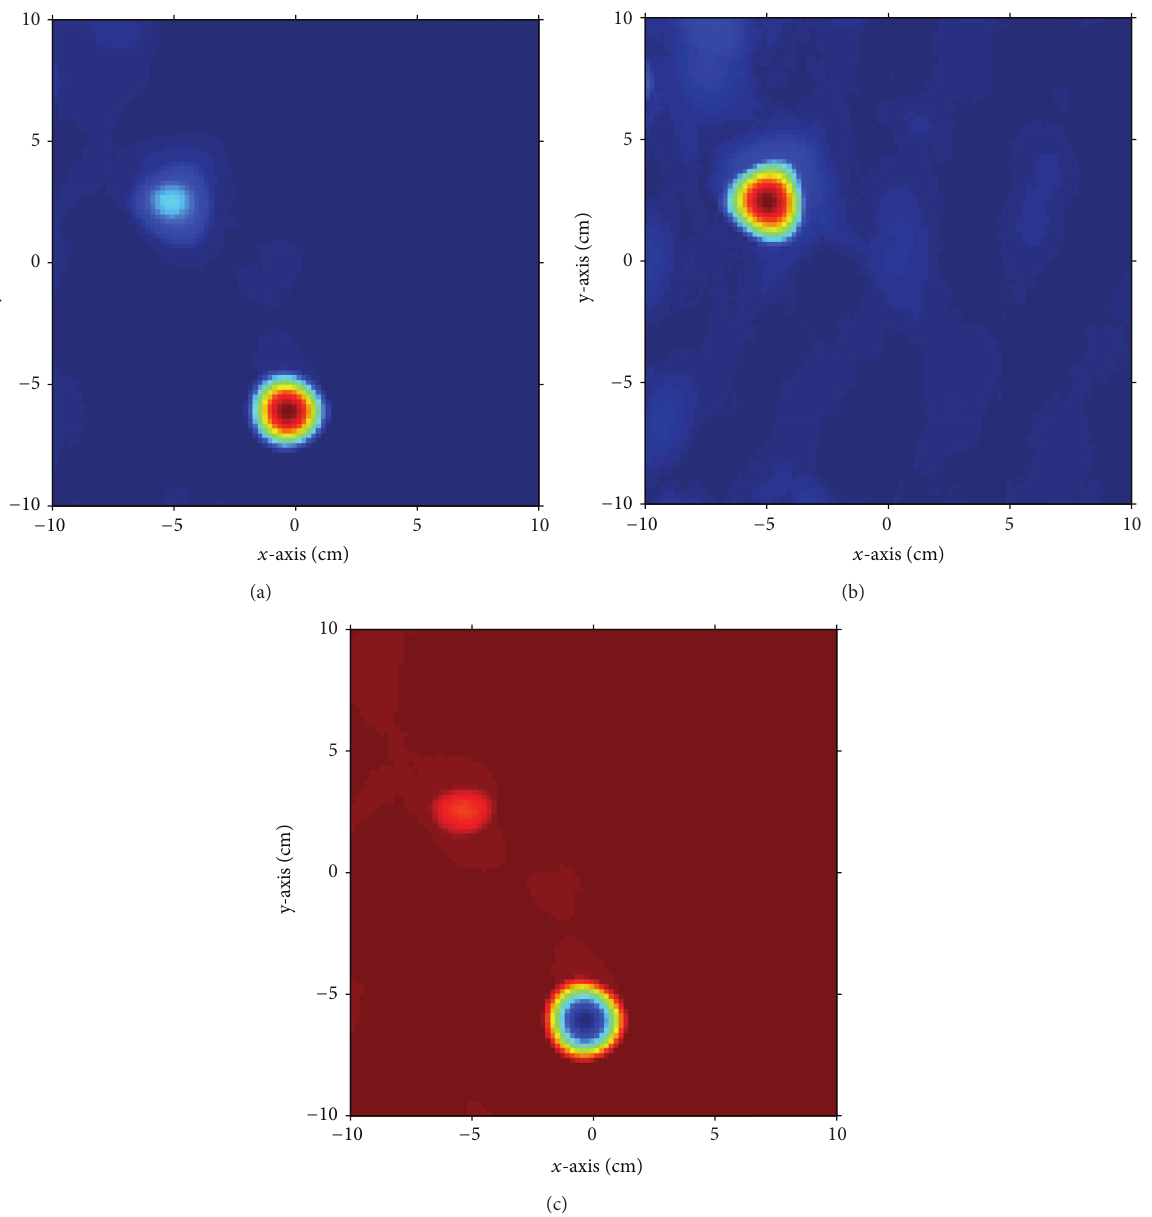
Figure 6: ART method with enforcement of physical bounds. (a) shows | 𝜀 𝛿 | , (b) shows Re ( 𝜀 𝛿 ) , and (c) shows Im ( 𝜀 𝛿 ) . All images are obtained with 𝜇 = 0.2 and are